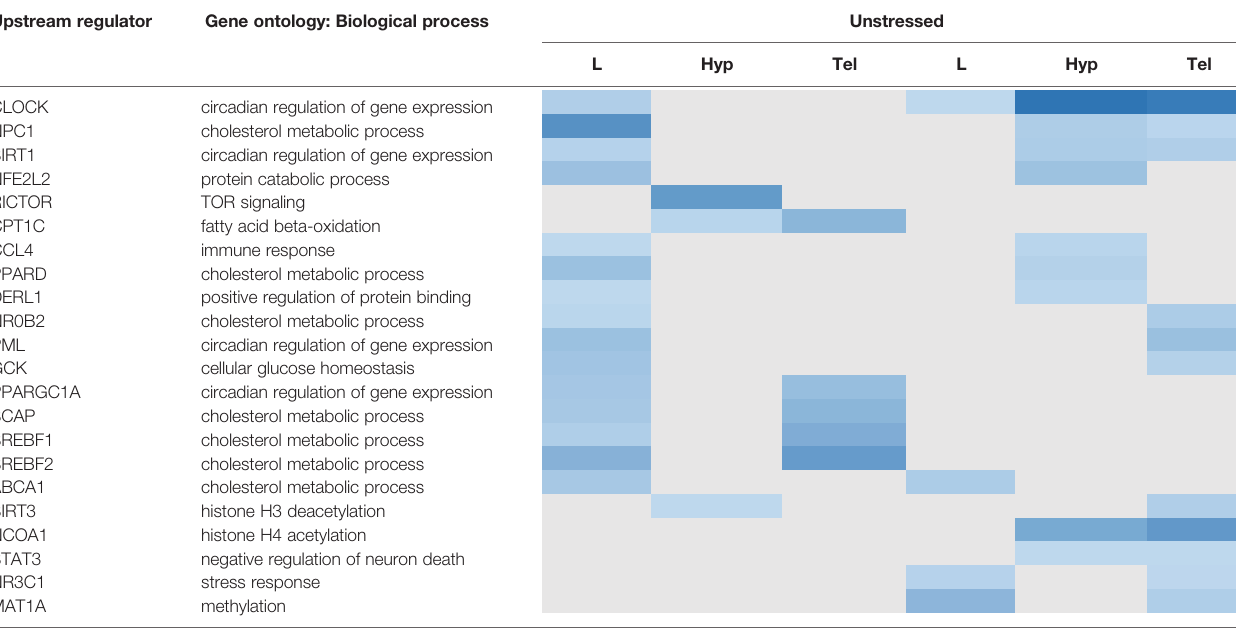
TABLE 2 | Top 5 predicted networks affected by developmental exposure to fl uoxetine. Group